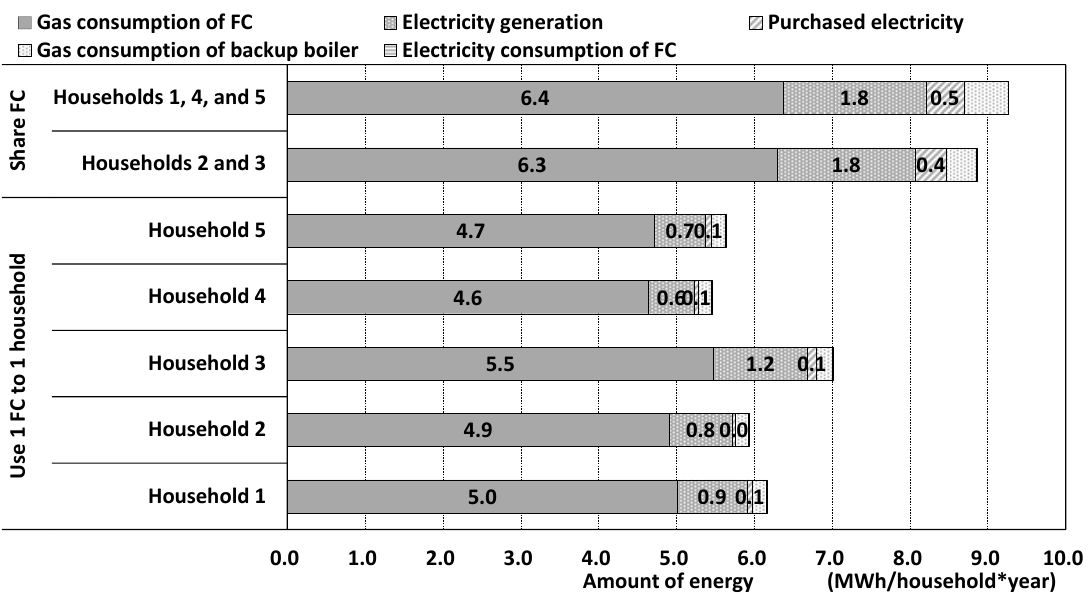
Figure 12. Yearly energy consumptions of simulating one SOFC–CGS for one household and multi-households.